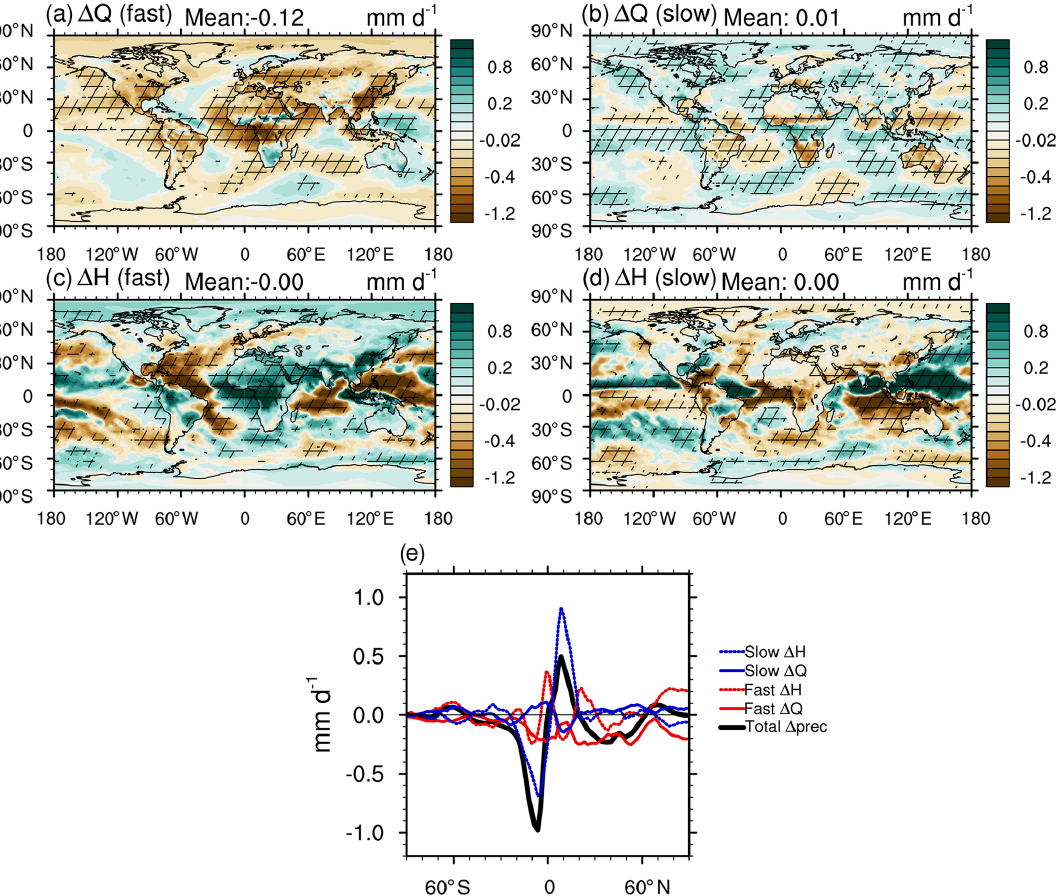
Figure 3. ECHAM6–HAM2 simulated geographical patterns of multi-annual mean changes in (a, b) atmospheric diabatic cooling ( (cid:49)Q ) and (c, d) dry static energy flux divergence ( (cid:49)H ) for (a, c) fast responses and (b, d) slow responses to 10-fold increased BC emission. Hatching indicates where the changes are significant (90% confidence interval through bootstrapping methods). (e) The zonal mean of total precipitation response and its decompositions, including fast and slow responses of diabatic cooling and dry static energy flux divergence. All of them are shown in equivalent precipitation units of mmd − 1